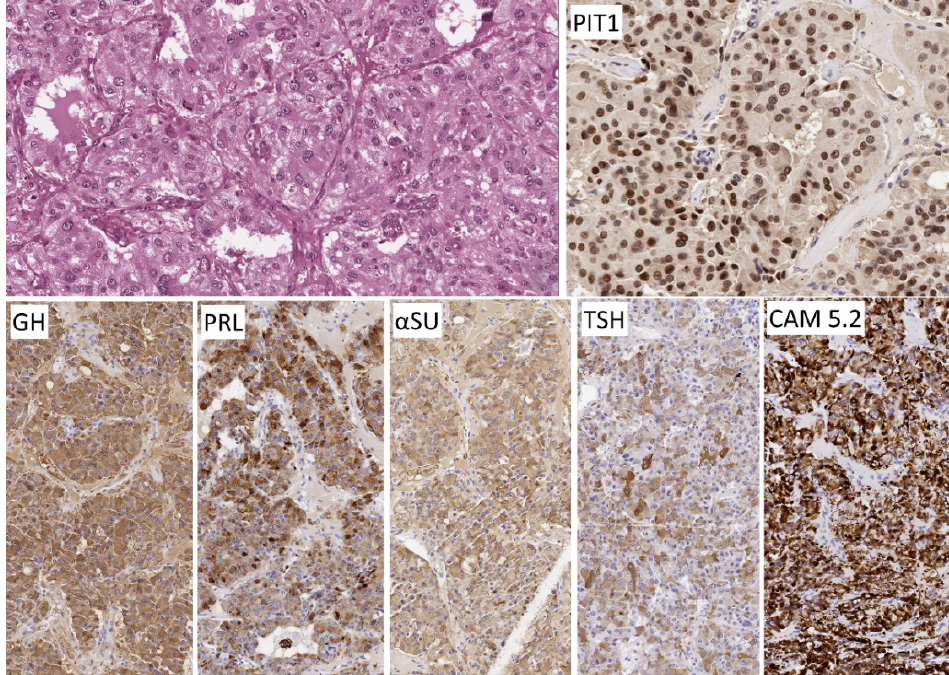
Figure 7. Morphology of immature PIT1-lineage tumor. The polygonal to spindle-shaped cells consistently express PIT1 that highlights the nuclear atypia and negatively staining intranuclear inclusions. Immunoreactivity for hormones and keratins is extremely variable as is the clinical presentation; this tumor that caused acromegaly and hyperthyroidism stains for GH and TSH, PRL and α SU. Keratin reactivity is intense as identified with CAM 5.2 and focal fibrous bodies are seen.